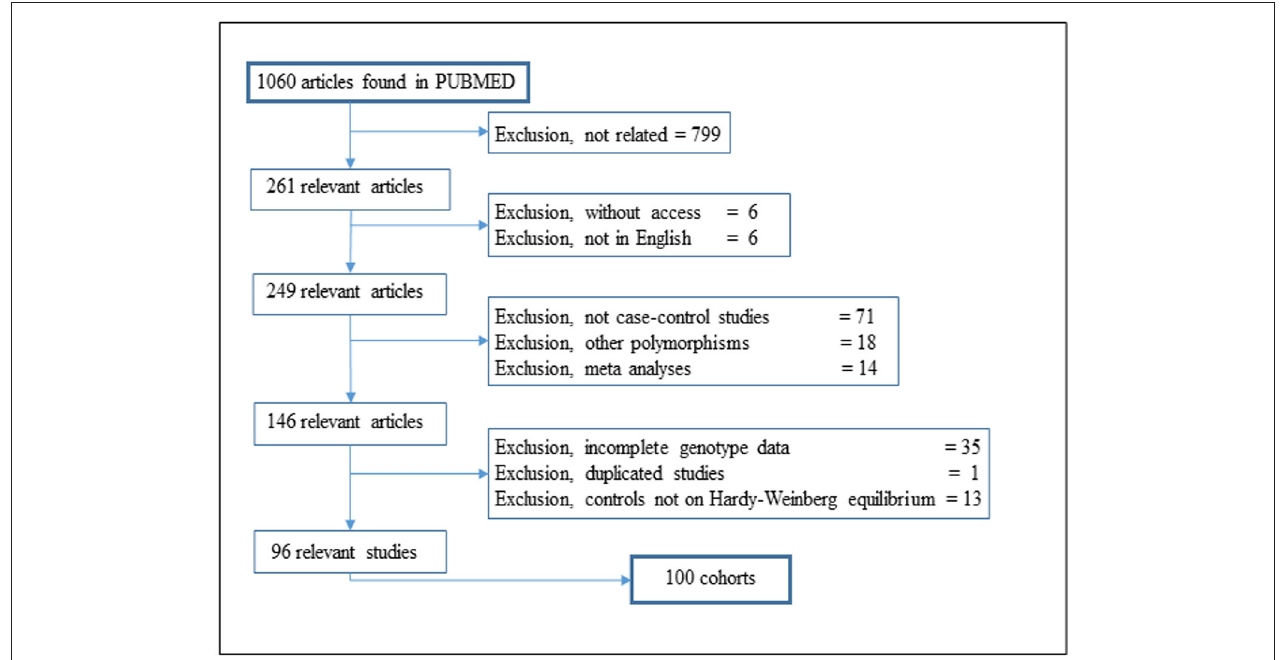
FIGURE 1 | Flow diagram of article selection for the